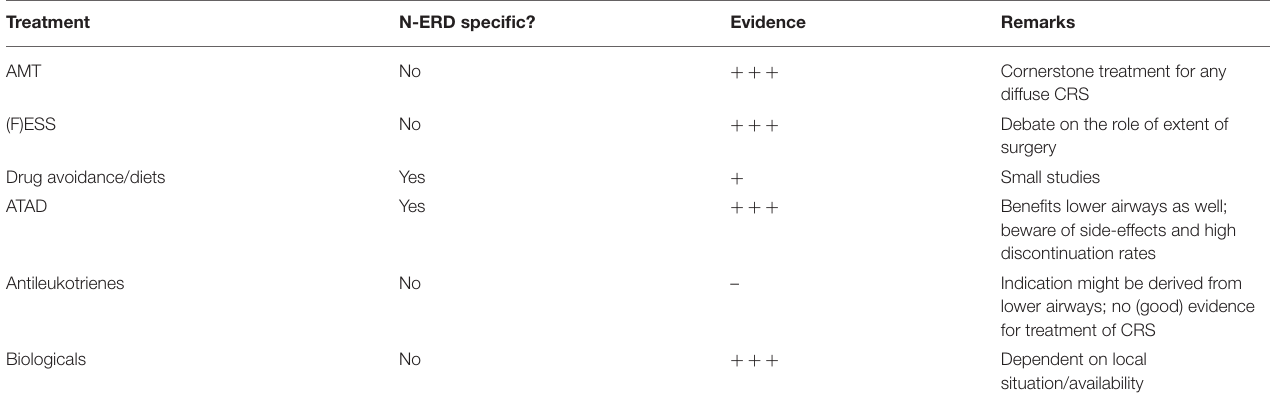
TABLE 1 | Summary of treatment options for primary diffuse Type 2 CRS in N-ERD.